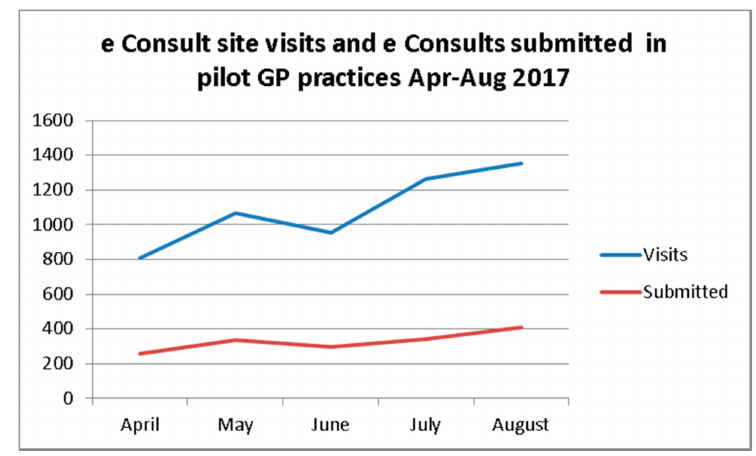
Figure 2. Comparison of eConsult site visits with eConsults submitted (April–August 2017).